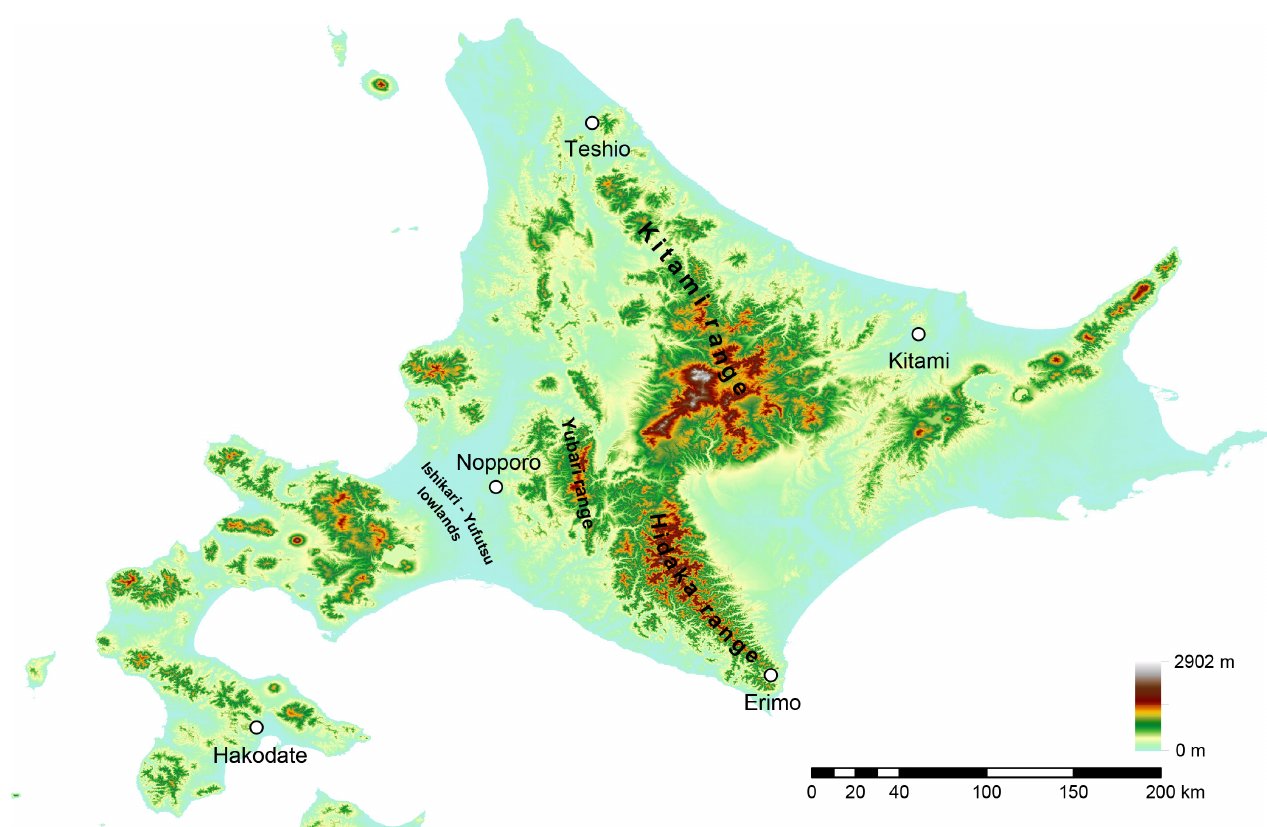
Fig 1. Sampling location of Hokkaido salamanders. Map showing the locality where each population was sampled. The localities are characterized by different mitochondrial DNA haplotype groups. Topographic map was projected by using ArcGIS 9.3 based on a 10-m grid digital elevation map provided by The Geospatial Information Authority of